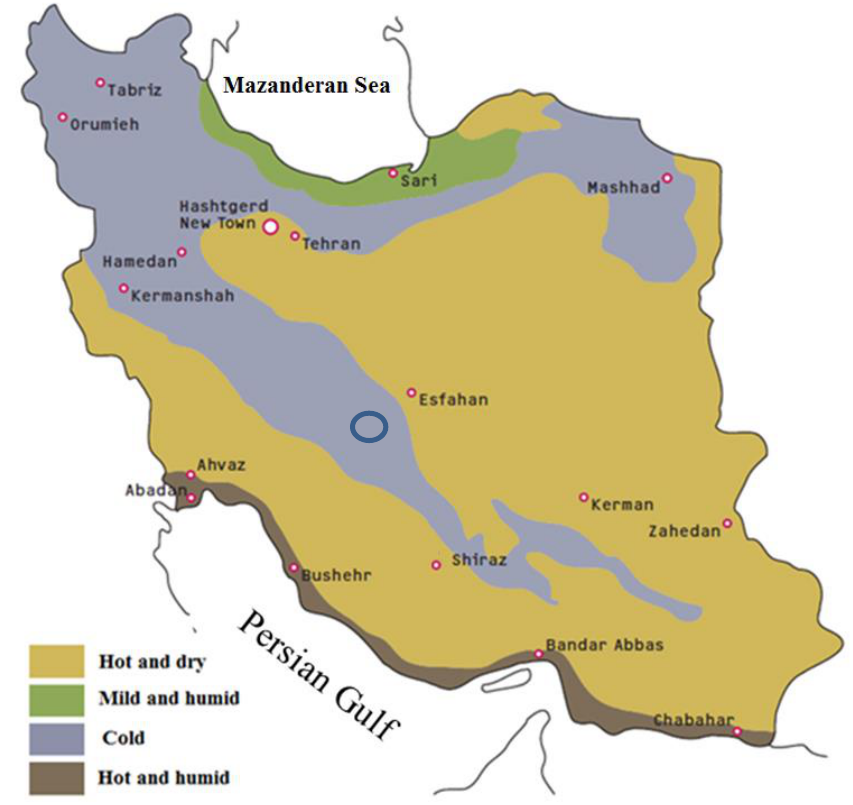
Figure 2. Climate divisions of Iran [31].